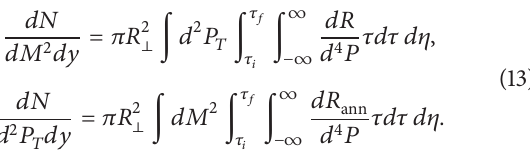
where 𝑓 𝑞(𝑞) is the phase space distribution function of the medium quarks (anti-quarks), V 𝑞𝑞 is the relative velocity between quark and anti-quark, and 𝜎 𝑙 tion.